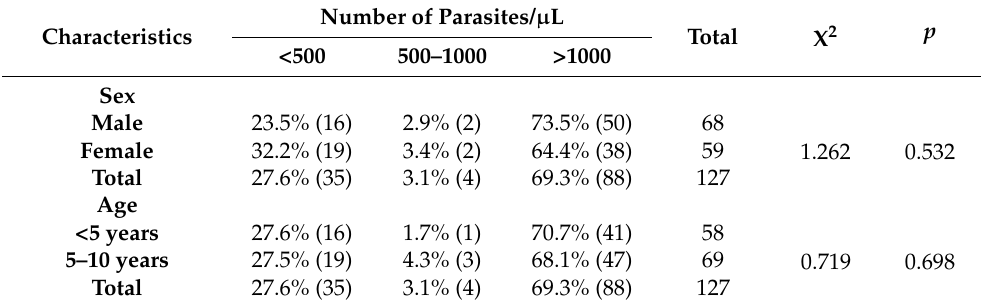
Table 6. Distribution of the parasite density in a microscopic study within gender and age.